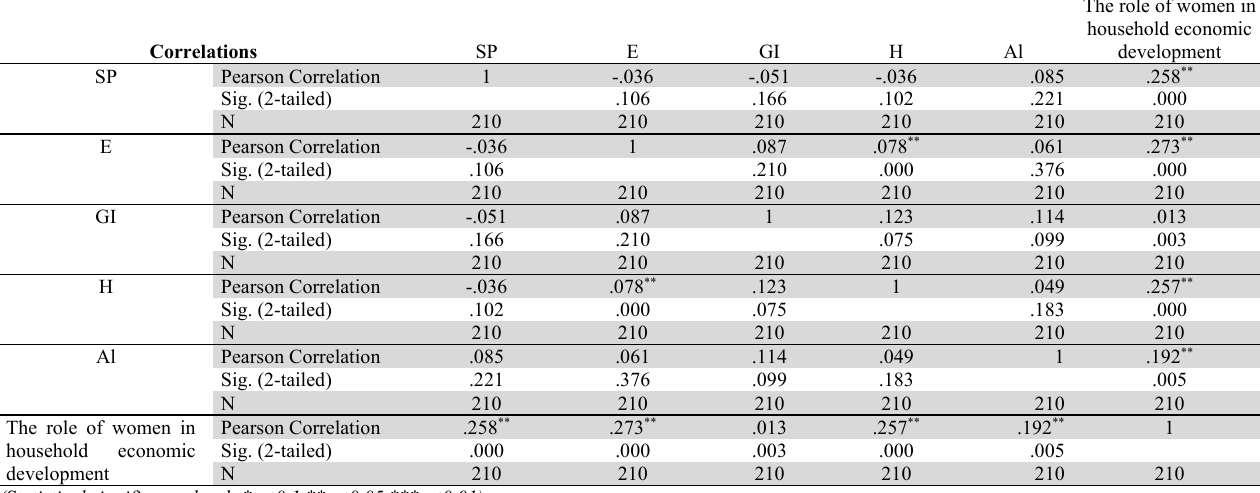
The role of women in household economic